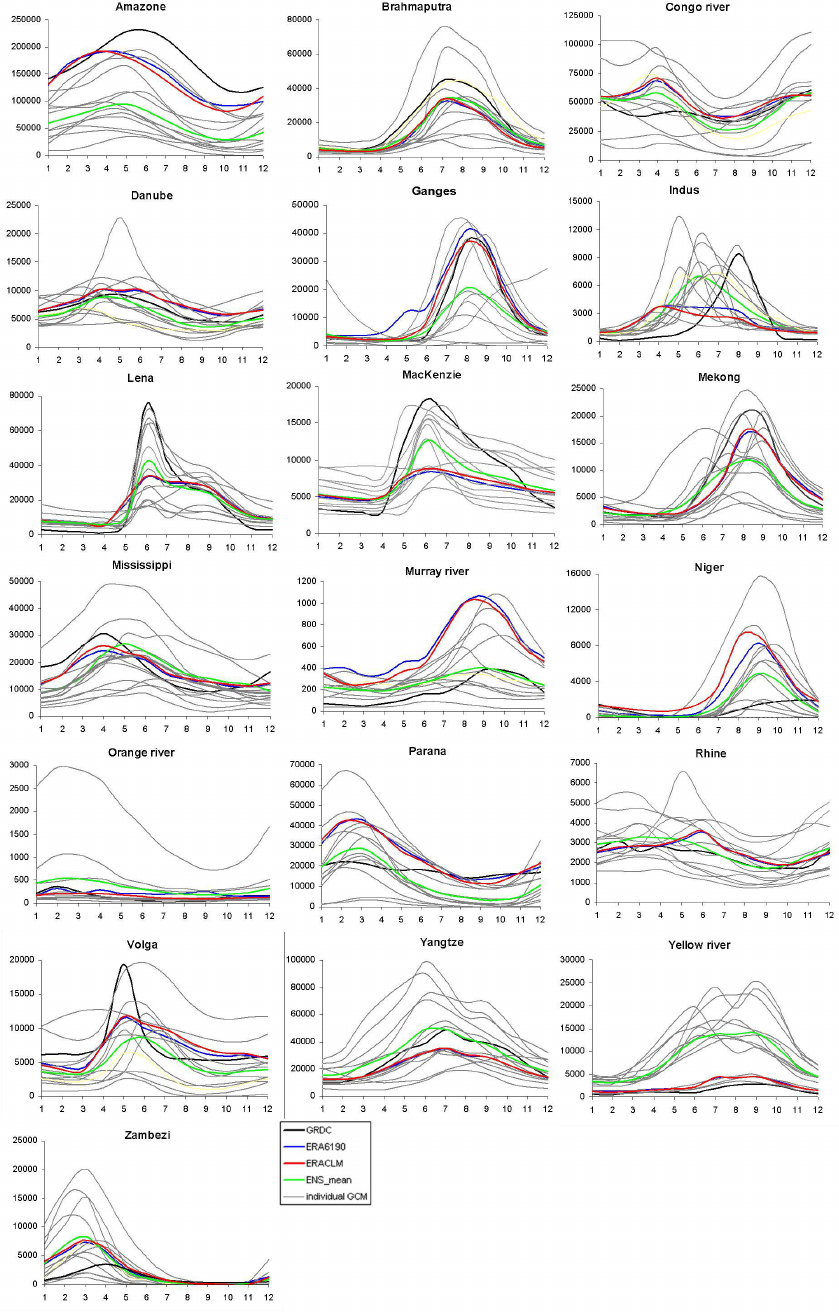
Figure 7: Hydrological regimes for all 19 catchments derived from discharges calculated for the period 1961–1990, with the average monthly discharge (m 3 /s) on the y-axis and the month numbers on the x-axis. Black line is annual mean observed discharge (GRDC), grey lines are PCR-GLOBWB based on individual non bias-corrected GCM datasets, green line is ensemble mean result, blue line is derived from PCR-GLOBWB run forced with the ERA6190 dataset and red line is derived from PCR-GLOBWB run forced with the ERACLM dataset.